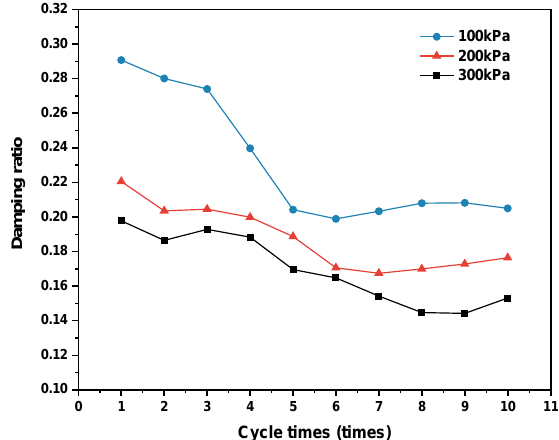
Figure 21. Development trends of shear stiffness under different vertical stresses.